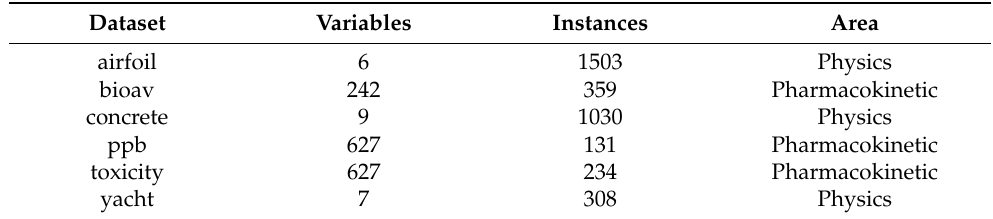
Table 1. Principal characteristics of the considered datasets: the number of variables, the number of instances, and the